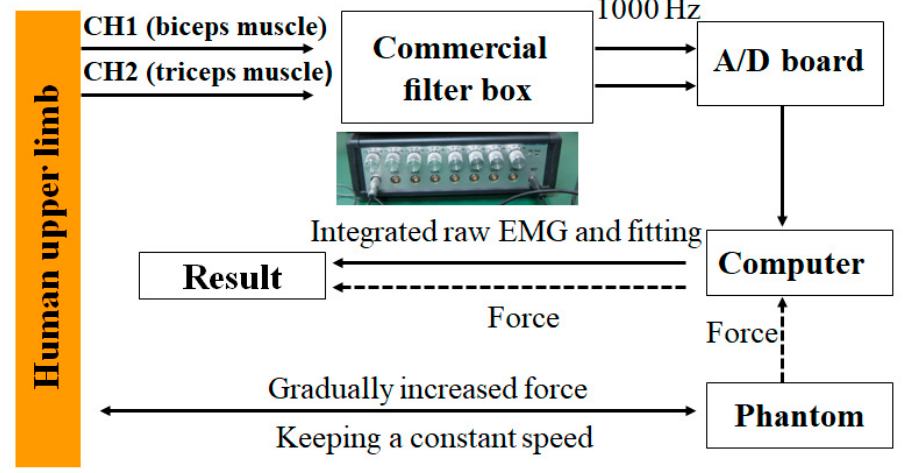
Figure 9. Data recording and processing process. EMG—electromyography; A/D—analog to digital.